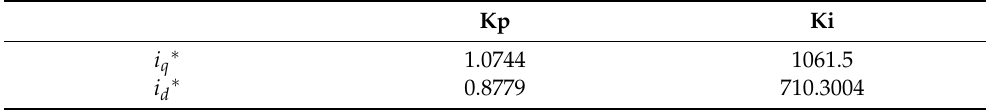
Table 2. The value of Kp and Ki in PI